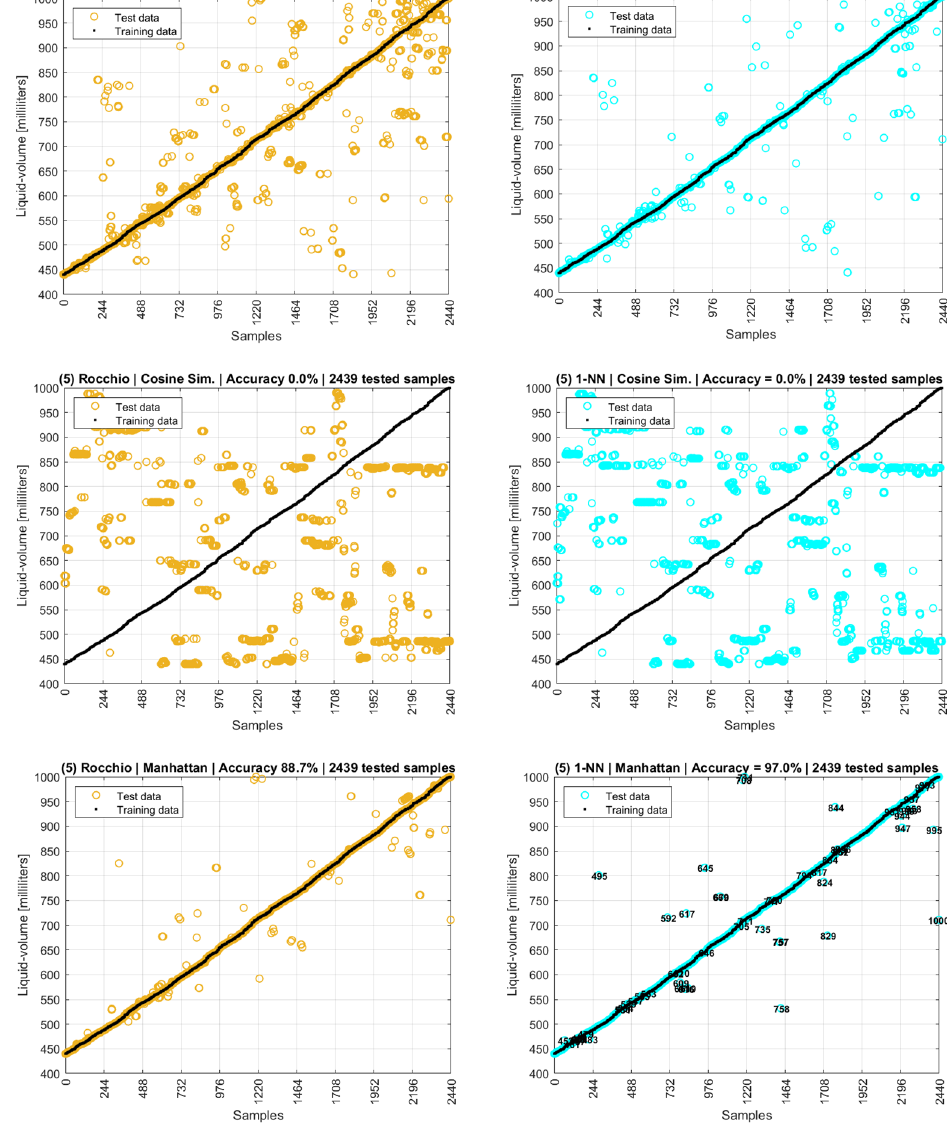
Figure 21. Fifth scenario. This figure has ten graphs distributed in two columns and five lines. Graphs on the left column are Rocchio and on the right are 1-NN. Each line stands for a different distance metric. Each graph title has the name of the distance used, the resulting accuracy, and number of tested samples.